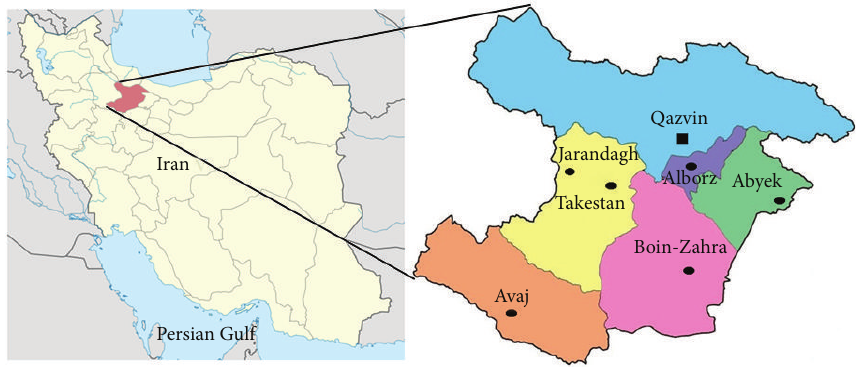
Figure 1: Location of Jarandagh and major counties of Qazvin Province on the Iranian map.